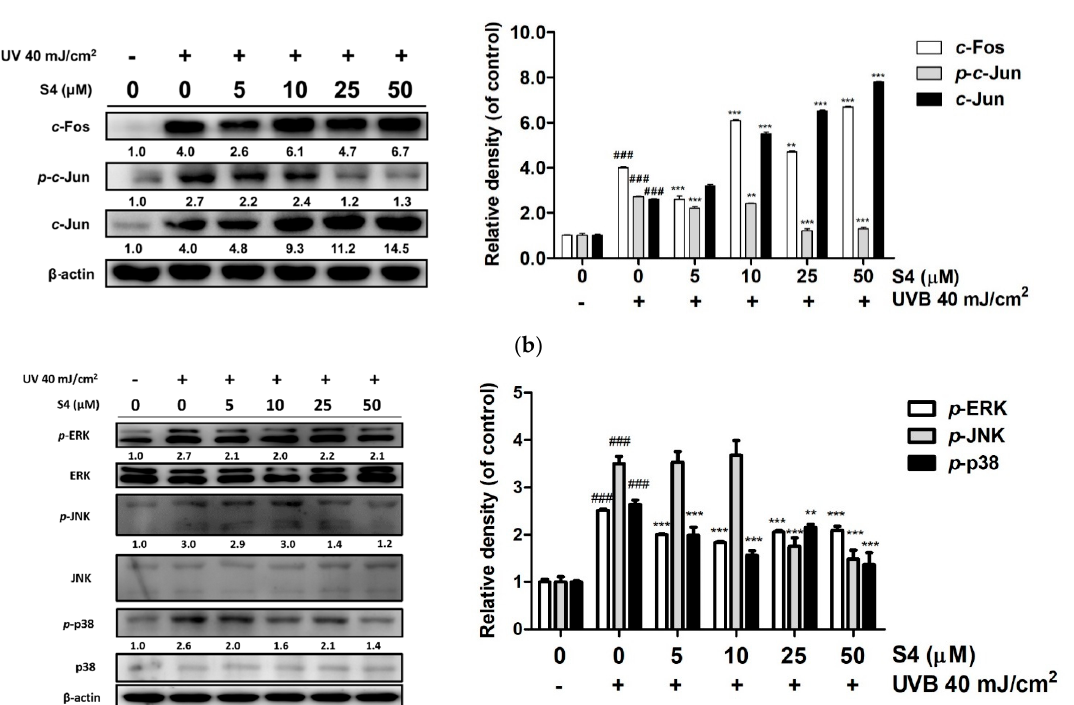
Figure 4. Effect of S4 on UVB-induced ( a ) AP-1 and ( b ) phosphorylation of mitogen-activated protein (MAP) kinases in human skin fibroblasts. The results were given as mean ± standard deviation (n = 3). Significant difference versus non-irradiation group: ###, p < 0.001. Significant difference versus non-treatment group: **, p < 0.01; ***, p < 0.001. non-treatment group: **, p < 0.01; ***, p <